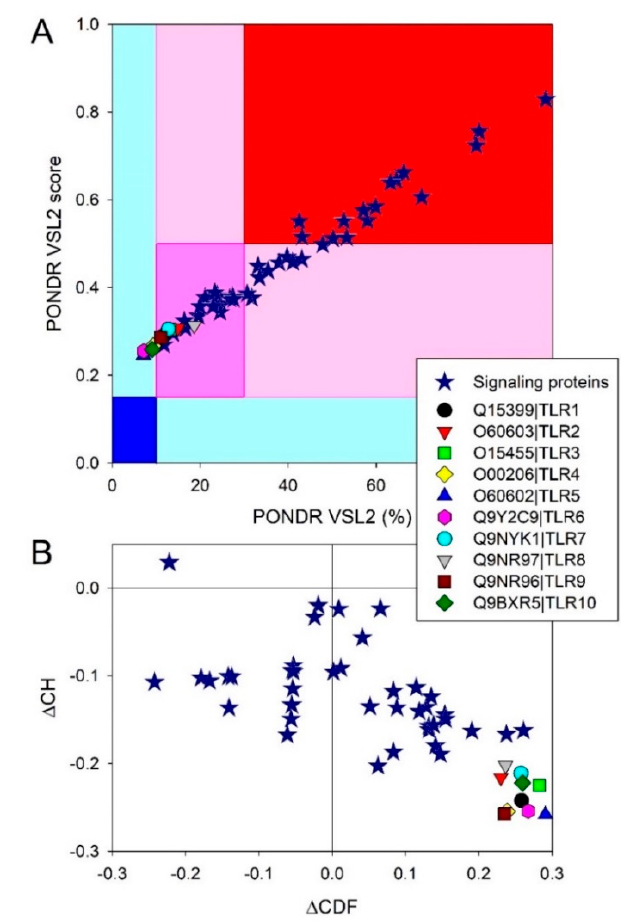
Figure 3. The global intrinsic disorder predisposition of human TLRs and major players in the TLR − triggered cellular pathways. ( A ) Analysis of 10 TLRs and 41 human proteins involved in TLR signaling based on the average disorder score (ADS) and percent of predicted disordered residues (PPIDR) as evaluated by PONDR ® VSL2 [128]. Larger values of each parameter correspond to a larger disorder propensity. Different color blocks indicate regions containing proteins with different levels of ordered, where mostly ordered, moderately disordered, and mostly disordered proteins are located within the blue, pink, and red blocks, respectively. If the two parameters (ADS and PPIDR) agree, the corresponding part of the background is shown by a dark color (blue or pink), whereas the light blue and light pink reflect areas in which only one of these criteria applies. ( B ) CH–CDF plot for 10 human TLRs and 41 major players of the TLR-based signaling. Intrinsic disorder predisposition analysis of all proteins was conducted using RIDAO web crawler, which aggregates the outputs of six well-known disorder predictors: PONDR ® VLXT [129], PONDR ® VL3 [130], PONDR ® VLS2 [131], PONDR ® FIT [132], IUPred2 (Short), and IUPred2 (Long) [133,134], and also provides the mean disorder predictions for query proteins by averaging the outputs of these six predictors. The corresponding disorder profiles of all query proteins are shown in the Supplementary Figure S1. For each query protein, the predicted percentage of intrinsically